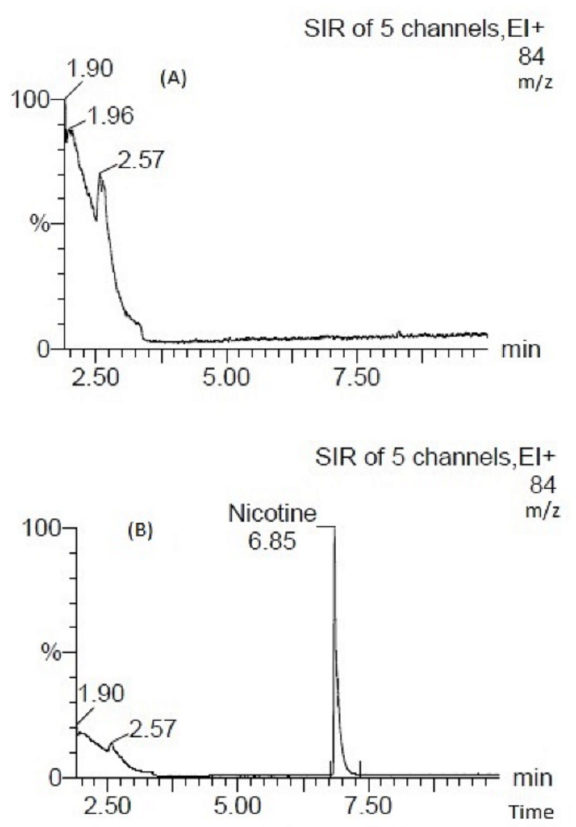
Figure 1. Vaping liquid extracted by mass chromatogram for single ion mass monitoring, m / z 84 in in ( A ) sample 0061 nicotine-free vaping liquid (floral flavour category), ( B ) sample 0084 labelled ( A ) sample 0061 nicotine-free vaping liquid ( fl oral fl avour category), ( B ) sample 0084 labelled as 1.5 mg/mL nicotine vaping liquid (confectionery category).